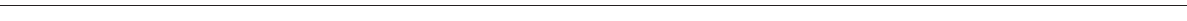
FIGURE 5 | adapted from Venugopal Menon et al. (193) [Copyright 2018, licensed under a Creative Commons Attribution (CC BY) license. http://creativecommons. org/licenses/by/4.0/]. (B) Model of thrombosis (17). (B.1) Layer-by-layer assembly of a tissue engineered medial layer (TEML) composed of human coronary artery smooth muscle cells in type I collagen, covered with an intimal layer (TEIL) composed of a HUVEC-seeded aligned PLA nanofibers scaffold (17). (B.2) the grafts were mounted into a modified parallel-plate flow chamber, (B.3) and were then perfused with fluorescently labeled human platelets under variable flow conditions. Exposing the TEML layer (representing endothelium-denuded blood vessels) resulted in a significant platelet adhesion and aggregation. (B.4) Shows platelet aggregation and adhesion in tissue engineered blood vessels (TEBVs) with confluent, partial and impaired (treated with FeCl 3 ) endothelium layer. Partial endothelium resulted in limited platelet aggregation in areas that lacked endothelial cells while impaired endothelium resulted in significant platelet aggregation on the construct. (B.5) Shows the effect of the anesthetic ketamine on platelet reactivity, which resulted in less adhesion and aggregation when compared to untreated platelets. (B.6) Shows platelet aggregates on the surface of TEML following treatment with 1mM ketamine. Figures adapted from Njoroge et al. (17) [Copyright 2021, licensed under a Creative Commons Attribution (CC BY) license. http://creativecommons.org/licenses/by/4.0/]. (C) Model of medial thickening in pulmonary arterial hypertension (PAH) (23). (C.1) Reference image showing elastic tissue staining of a pulmonary artery from a PAH patient. (C.2) Generation of a 3D PAH media layer formed of human smooth muscle cells derived from PAH patients (23). (C.3) Stimulation of medial thickening was achieved using platelet-derived growth factor BB (PDGF-BB), and (C.4) the thickening is inhibited by the PDGF-BB inhibitor imatinib (1 µ g/mL). (C.5) The effect of PAH drugs bosentan, MRE-269;the active metabolite of selexipag, and tadalafil was evaluated and confirmed to suppress medial thickening. Furthermore, bosentan or tadalafil reduced the mRNA expression of the proliferation marker Cyclin D1 (CCND1). Figures were adapted from Morii et al. (23) [Copyright 2020, under the terms of Creative Commons Attribution License (CC BY). https://creativecommons.